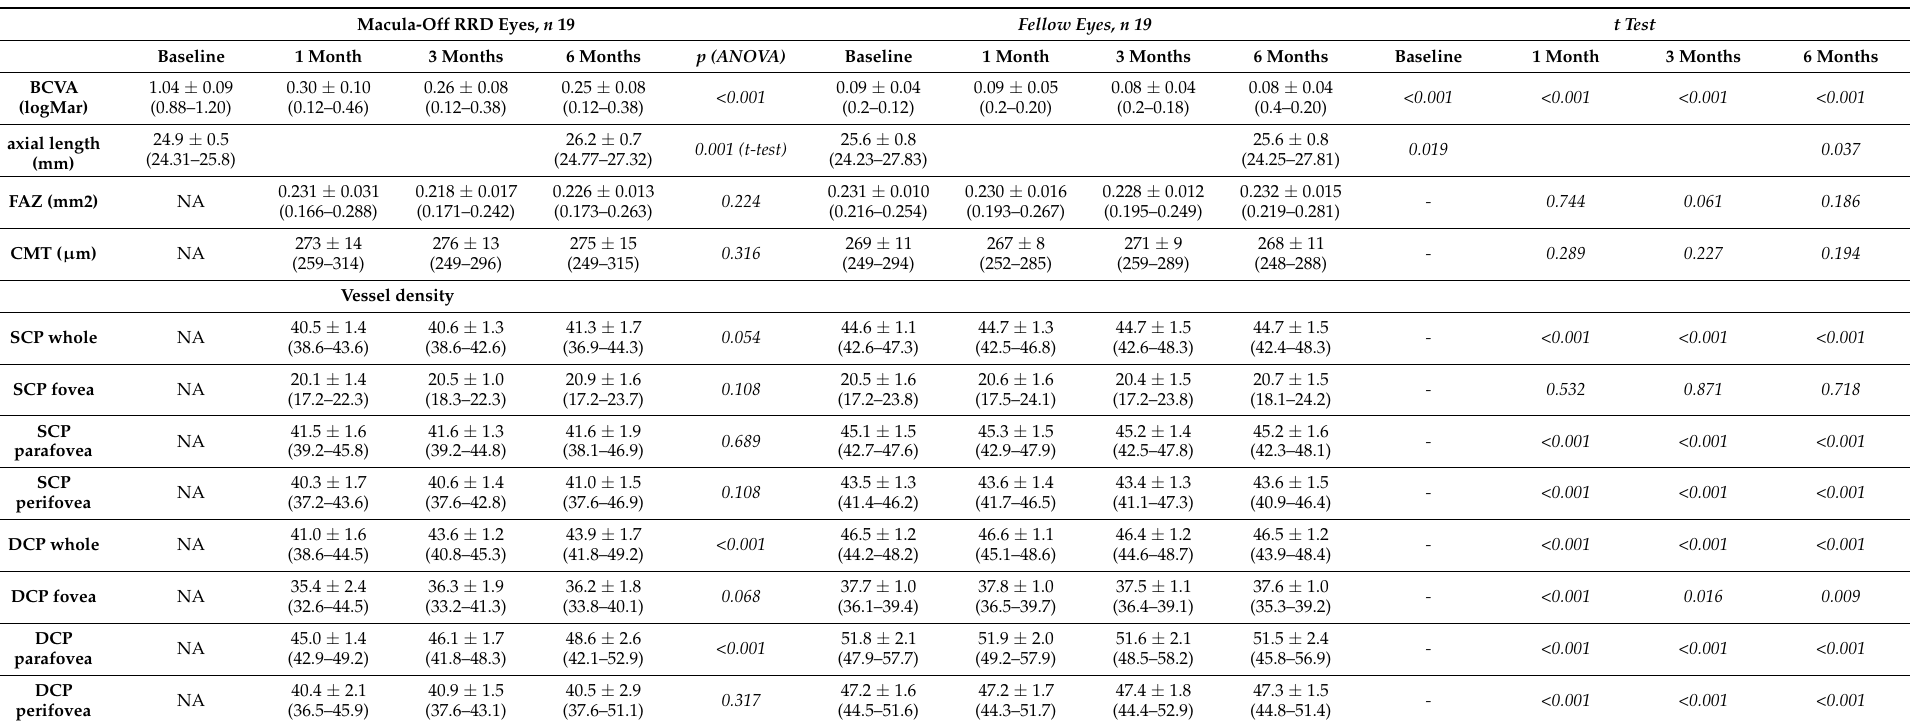
Table 3. Clinical and OCTA parameters of the macula-off RRD